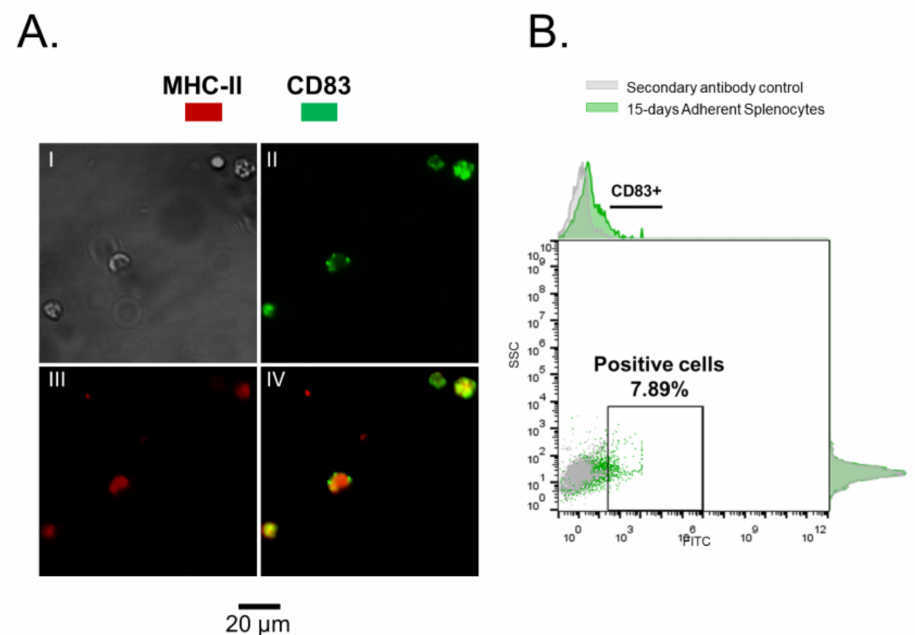
Figure 3. Adherent splenocytes, cultured for 15 days with rIFN γ as inducer. ( A ). Immunofluorescence (IFAT) on mononuclear splenocytes, I—phase contrast, II—in green CD83, III—in red MHC II, IV— Merged. ( B ). CD83 + cells. In gray—secondary antibody control. In green—adherent Splenocytes with rIFN γ